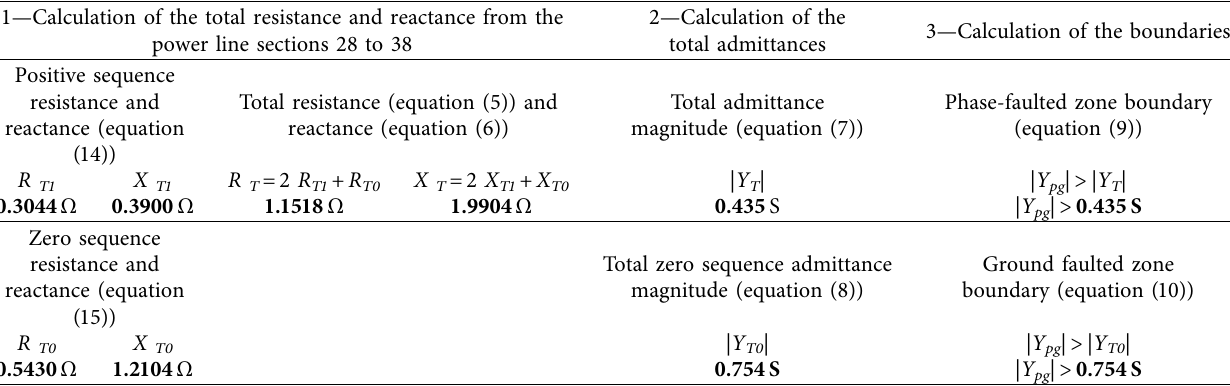
Table 4: Steps to calculate the phase/ground boundaries of the faulted